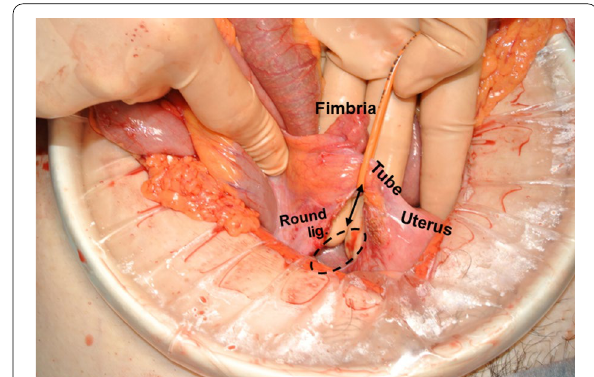
Fig. 3 Surgical findings. Incarcerated ileal loop was released after widening the broad ligament of the uterus (double-headed arrow). The original hernia orifice (defect in the mesometrium) is depicted with a dotted oblong